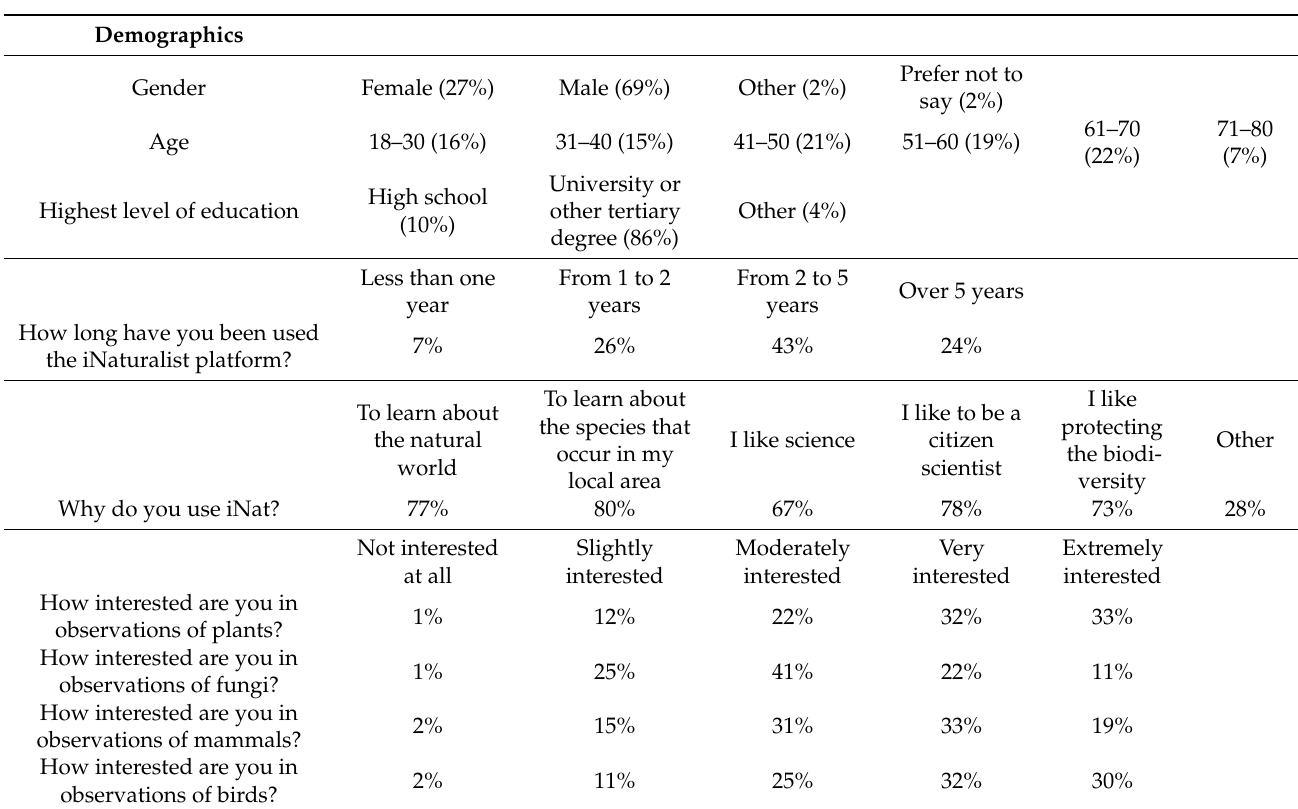
Table 4. Responses summary for questionnaire interrogating iNaturalist user perceptions and moti- vations regarding mosquito